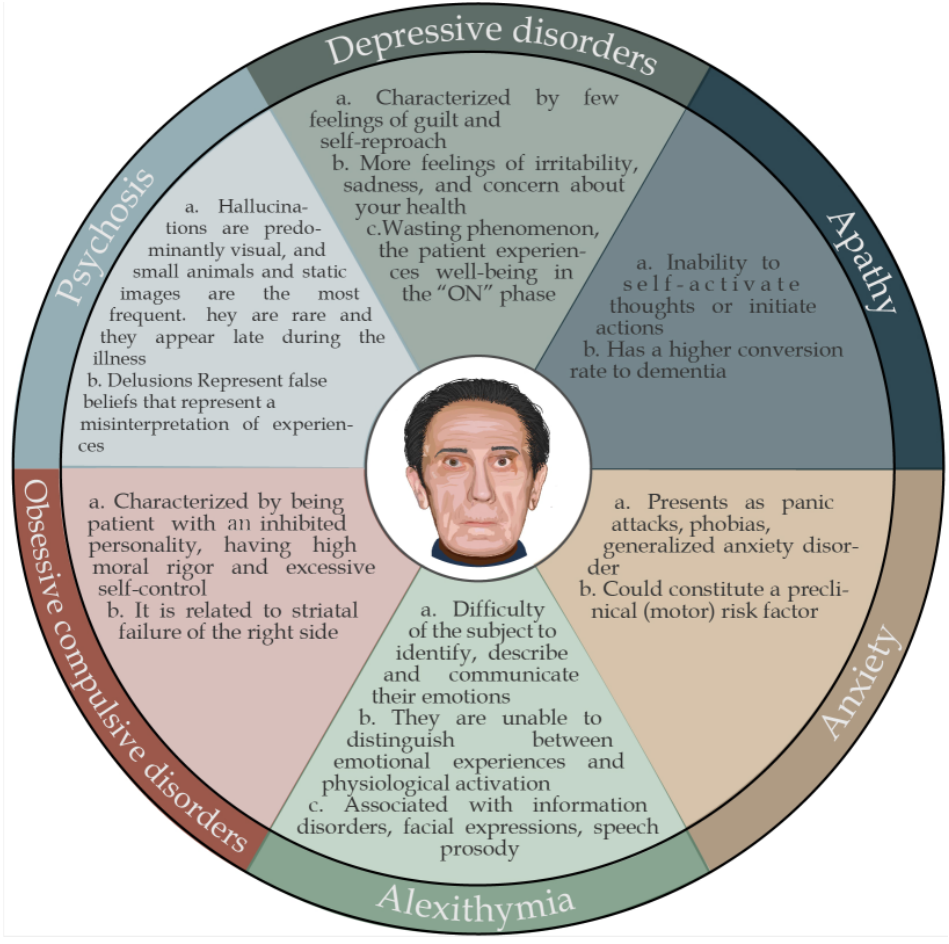
Figure 5. Summary of characteristic neuropsychiatric alterations in Parkinson’s disease.